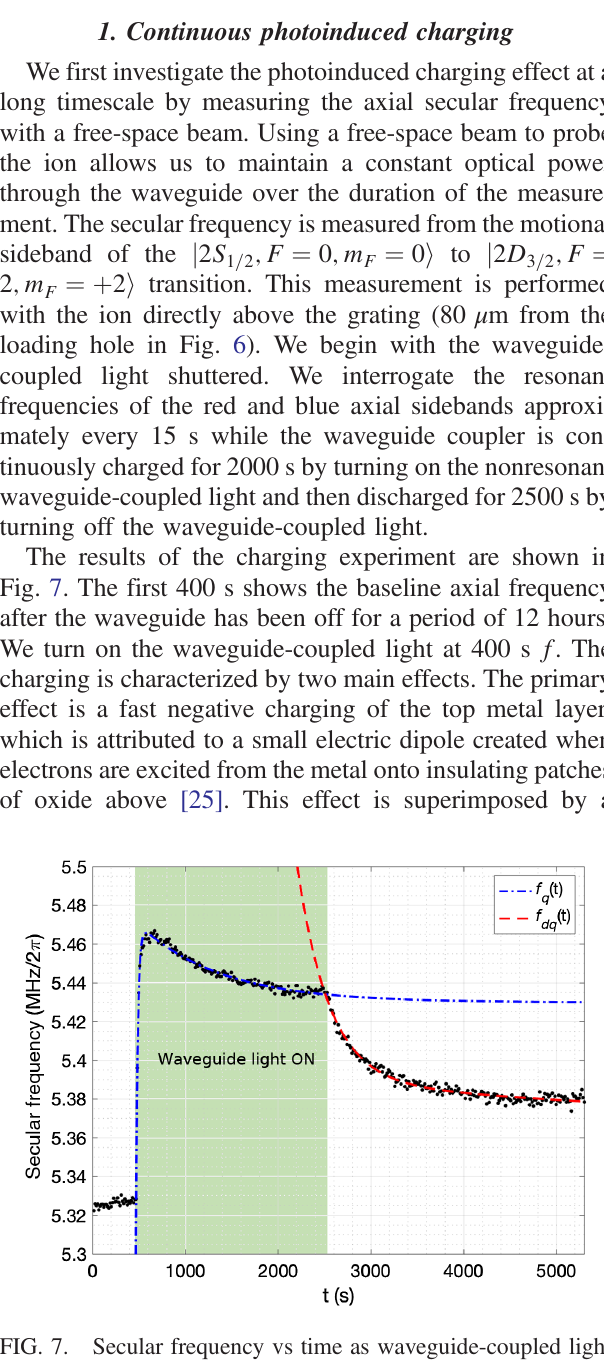
FIG. 7. Secular frequency vs time as waveguide-coupled light is turned on and off. Secular frequency is measured with a free- space beam tuned to the Δ m F ¼ þ 2 transition. Between 500 s and 2500 s, the waveguide-coupled light is turned on (green) and servoed to a constant power. The two opposing charge effects are attributed to the metal and dielectric layers as described in Ref. [25]. Fitted lines for the charging (blue dot dashed) and discharging (red dashed) are described by Eqs. (1) and